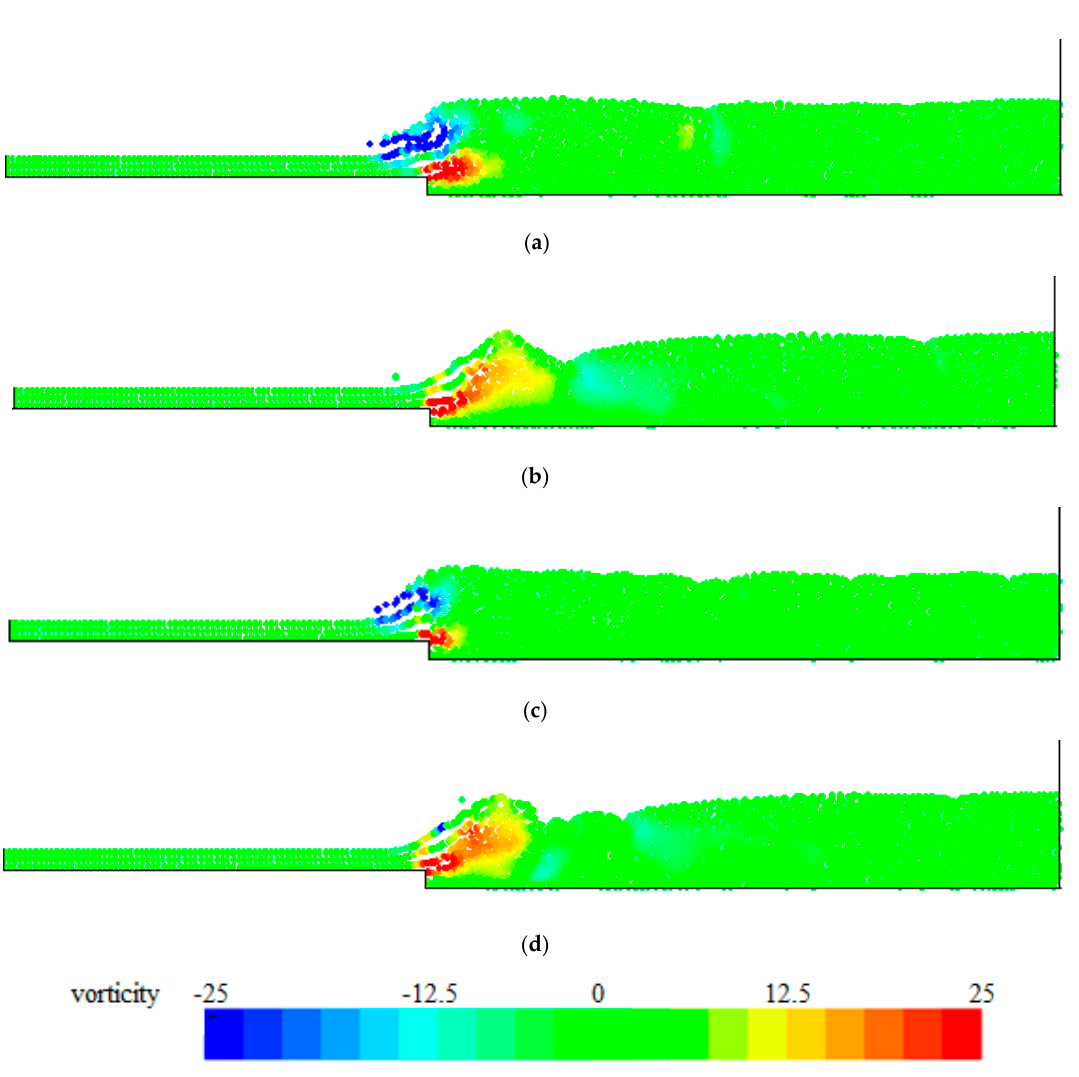
Figure 7. Instantaneous SPH vorticity field in the SPH simulation of Test T1a: ( a ) t = 8 s; ( b ) t = 17 s; ( c ) t = 22 s; and ( d ) t = 27 s. Vorticity values in the colour scale are expressed in s − 1 . (http://creativecommons.org/licenses/by/4.0/).